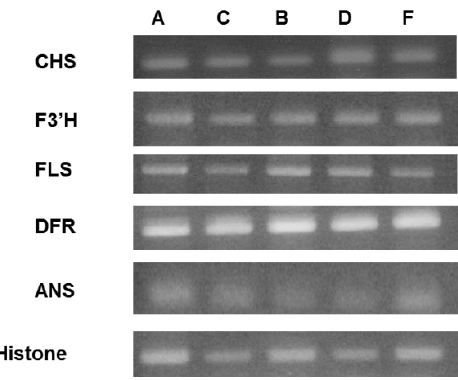
Figure 7. Expression level of flavan-3-ol biosynthesis enzyme encoding genes in raspberry leaves under conditions A, B, C, D, and F. Total RNA was extracted from fresh leaves after 7 days LED light irradiation treatment and used for sqRT-PCR analysis.